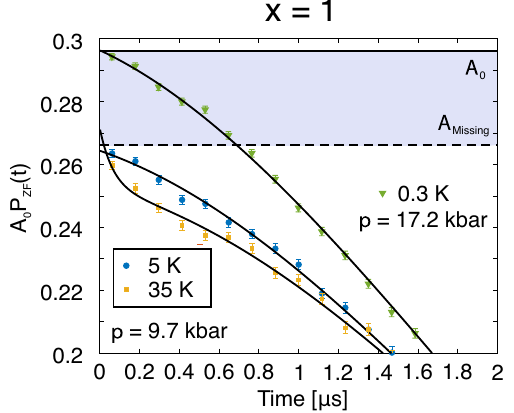
Figure 3. Zero field time spectra collected at T = 5 and 35 K at p = 9.7 kbar (yellow and blue) and T = 0.3 K at p = 17.2 kbar (green) for the x = 1 compound. The solid lines represents fits using Eq. (1) with n = 1 but with f 1 = 0 MHz for T = 35 K and n = 0 for T = 5 K. The horizontal solid black line is the estimated A 0 while the missing fraction ( A m issing ) is the band between A 0 the dashed black horizontal line. The p = 17.2 kbar spectra was collected using a different cryostat and the spectra were shifted down by 0.13 units to match the estimated A 0 for the nominal cryostat of this study (the specific value of A 0 is cryostat dependent).